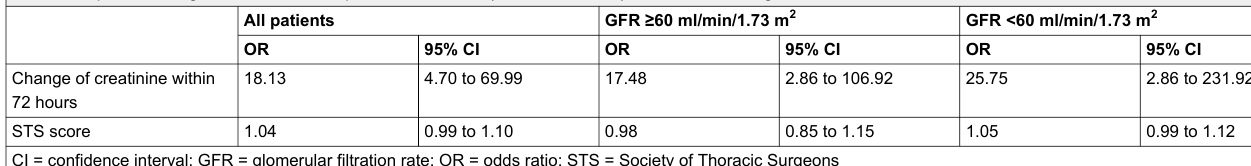
Table 4 : Impact of change of creatinine as a predictor of events (n for events = 31) at multivariable regression. All patients